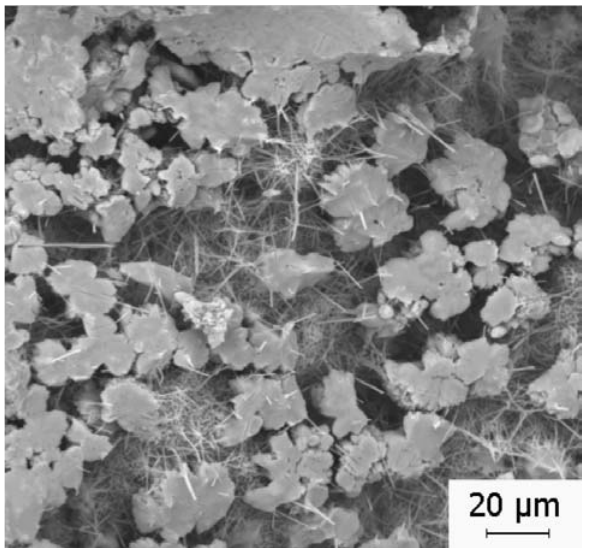
Figure 6. SEM micrograph of the porosity and disordered development of anhydrite crystals on the (Rz) Matrix (CPII-Z-32 cement/sand) after 28 days of aging.